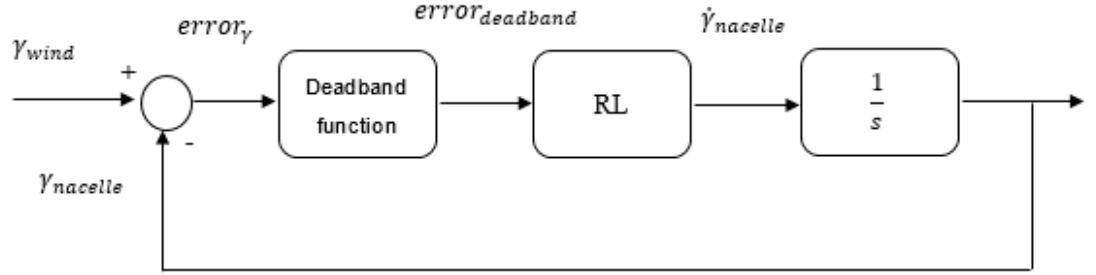
Figure 8. Block diagram of a RL based yaw control system.